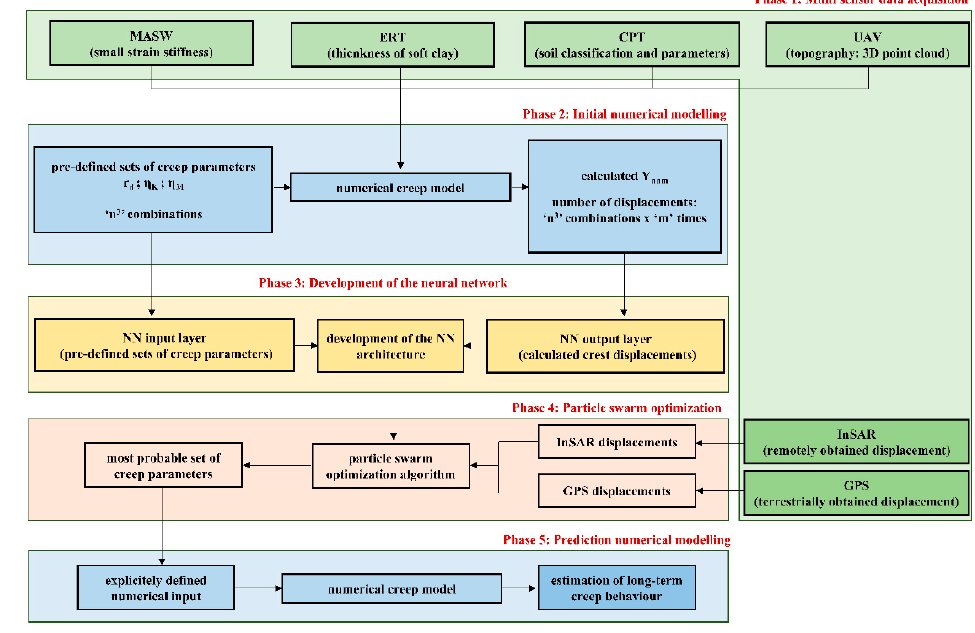
Figure 3. A framework for estimation of long-term creep behavior of soft soils.